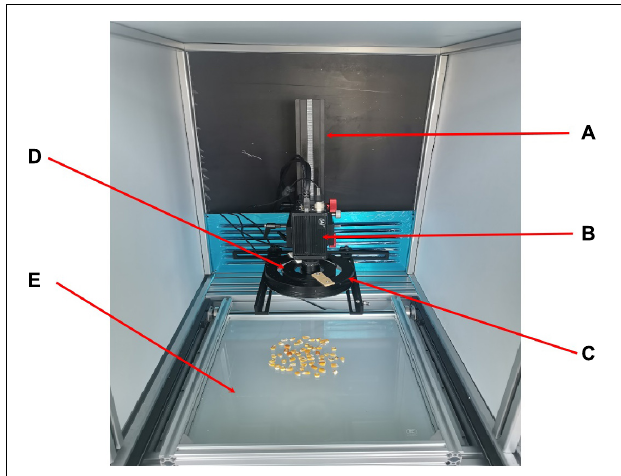
FIGURE 1 | Image acquisition platform. (A) Support, (B) camera, (C) circular white light source, (D) circular near-infrared light source, and (E) white backlight.